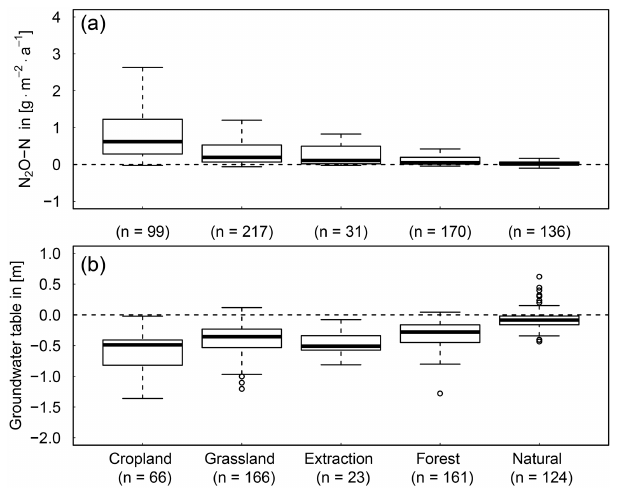
Figure 2. Box plots for N 2 O fluxes (a) and mean annual groundwa- ter table (b) for five different land use categories (cropland, grass- land, peat extraction, forest and natural sites). N 2 O fluxes are shown without outliers and n indicates the number of measurement per cat- egory. Figure 3. The scatter plots show (a) the N 2 O flux relationship to